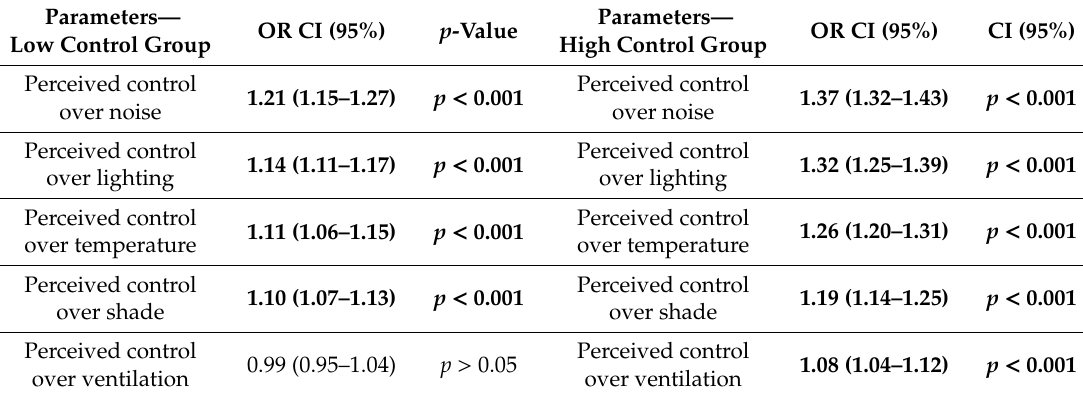
Table 8. Relations between perceived control in low and high control groups and perceived overall